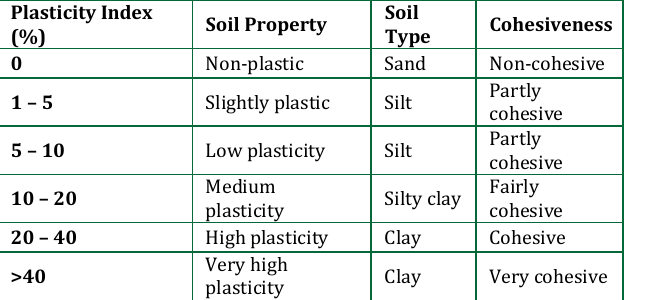
Table 4: Characteristics of Soils with Different Plasticity Index (Sowers,